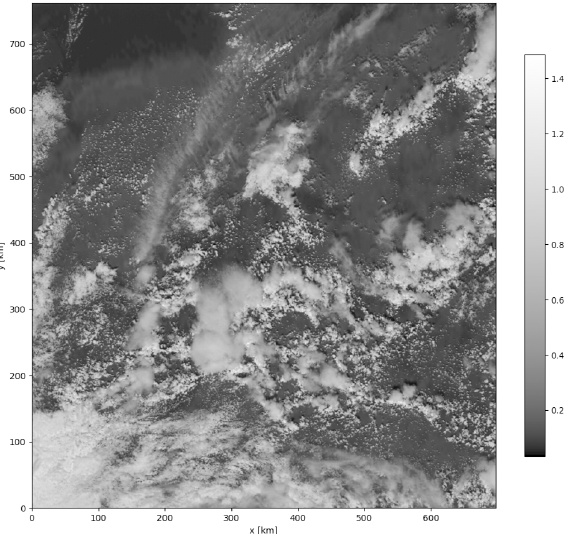
Figure 9. Reflectance simulation for Sentinel-3 SLSTR, band 1, centred at